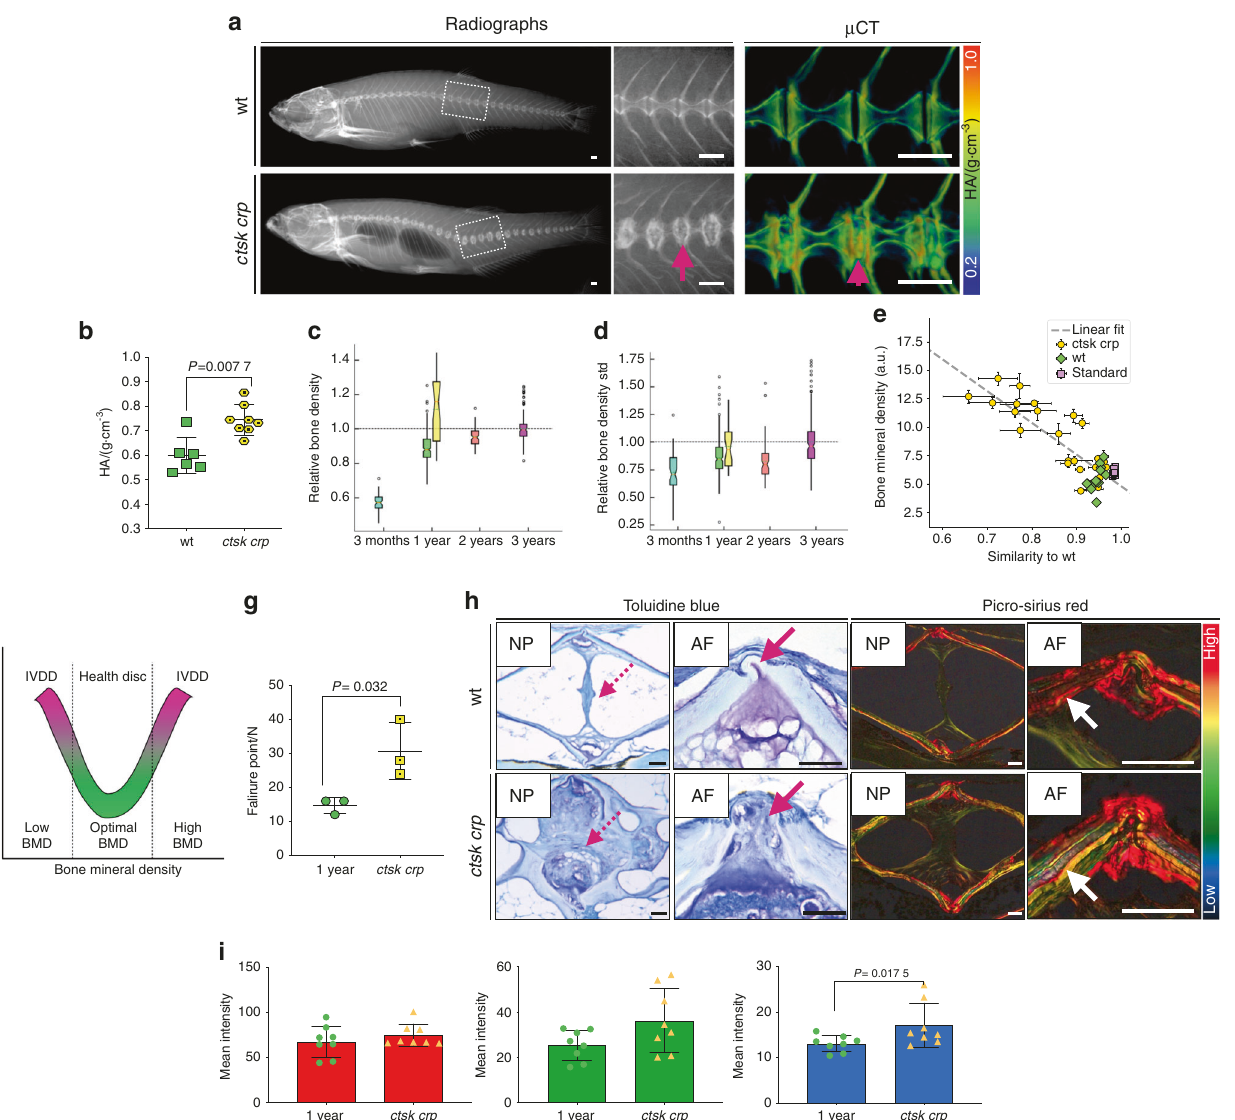
Fig. 7 Increased bone density in cathepsin K crp accompanied by premature IVDD. a Radiographs and 3D volumetric rendering from μ CT images of 1-year-old wt zebra fi sh and 1-year-old ctsk crps , color coded for bone density (TMD). Note the dramatic IVD calci fi cation in ctsk crps (arrow). Scale bars = 500 μ m. b TMD showing differential density in ctsk crps [wt n = 6 (3 males, 3 females), ctsk crps n = 8 (4 males, 4 females)]. Standard fi sh lengths: wt = 3.5 (0.3 SD); ctsk crp = 3.5 cm (0.09 SD). The graph was generated in Prism 8. Nonparametric, two-tailed, Mann – Whitney test; data are the mean and SD. P values are indicated. c Relative bone density from the vertebral centra in aging fi sh. The notch plot was scaled by the average value from the 3-year-old centra (cyan = 3 months wt; green = 1-year old wt; yellow = 1-year-old ctsk crps; orange = 2-year-old wt; magenta = 3-year-old wt). The graph was generated in Python. d Within-sample standard deviation if bone density. The notch plot was scaled by its average value from the 3-year-old centra (cyan = 3-month-old wt; green = 1-year-old wt; yellow = 1- year-old ctsk crp; orange = 2-year-old wt; magenta = 3-year-old wt). The graph was generated in Python. e Cross-correlation between mineral density and wt morphology of the discs was calculated for wt, ctsk crp and wt standard samples. Pearson correlation coef fi cient = − 0.85, P = 7.8e − 14 . The graph was generated in Python. f Proposed U-shaped model to describe the association between BMD and IVDD. Either an abnormal increase or decrease in BMD is linked to IVDD. g Failure point during vertebral compression. Nonparametric, two-tailed, t -tests; data are the mean and SD. P values are indicated. The graph was generated in Prism 8. h Histological sections of wt and ctsk crp (1 year) zebra fi sh stained with toluidine blue and picrosirius red, with a focus on the NP and AF regions. Higher magni fi cation of the AF from another histological section is shown on the right. Disorganized NP (dashed arrows, toluidine blue) and abnormal AF, displaying loss of the elastin layer (arrows, toluidine blue), were detected in the affected IVD of c tsk crps . Picrosirius red staining shows different colors in the bone of ctsk crps (higher magni fi cation), indicating bone quality impairment (white arrow). Scale bars = 50 μ m. i Quanti fi cation of the thickness of collagen fi bers from picrosirius red staining (blue = thin, green = medium, red = thick) (1-year-old n = 8, ctsk crp n = 8). Parametric, two-tailed, T -test; data are the mean and SD. P values are indicated. The graph was generated in Prism